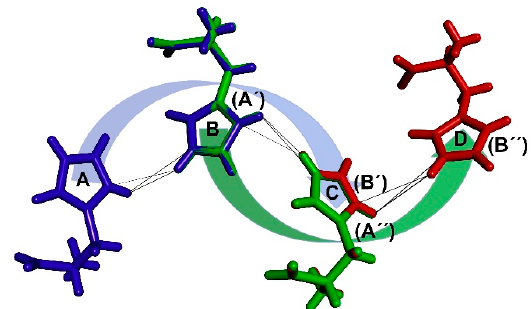
Figure 5. Chain generation principle described using 0–0–0 combination of angles; blue—original pair, green—pair copy placing molecule A’ into B position generating molecule C (B’); red—2 nd pair copy placing molecule A’’ into B’ position generating molecule D (B’’).